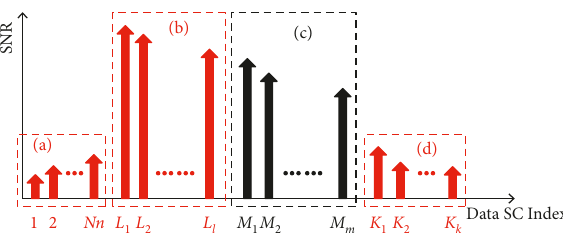
Figure 3: The qualitative analysis of the relationship between the SNR and the SC index in the VLC-based intelligent transportation